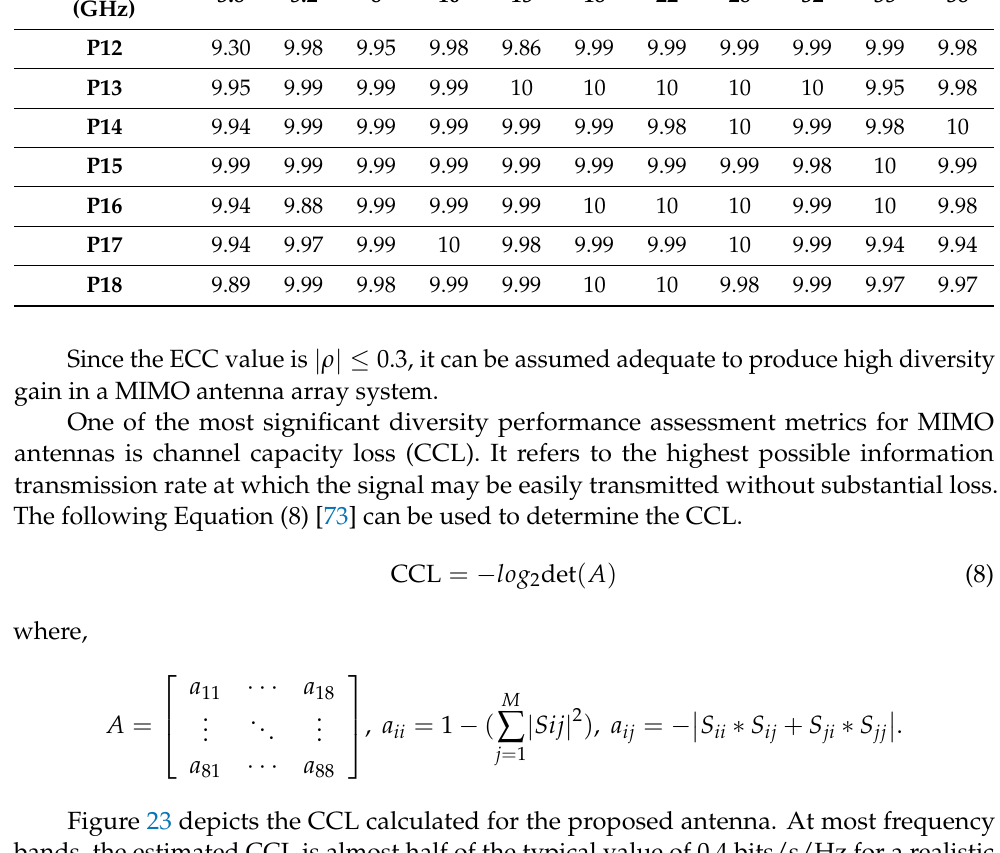
Table 5. The simulated GD values for between Port 1 and other ports at different frequencies. Ports/Frequency